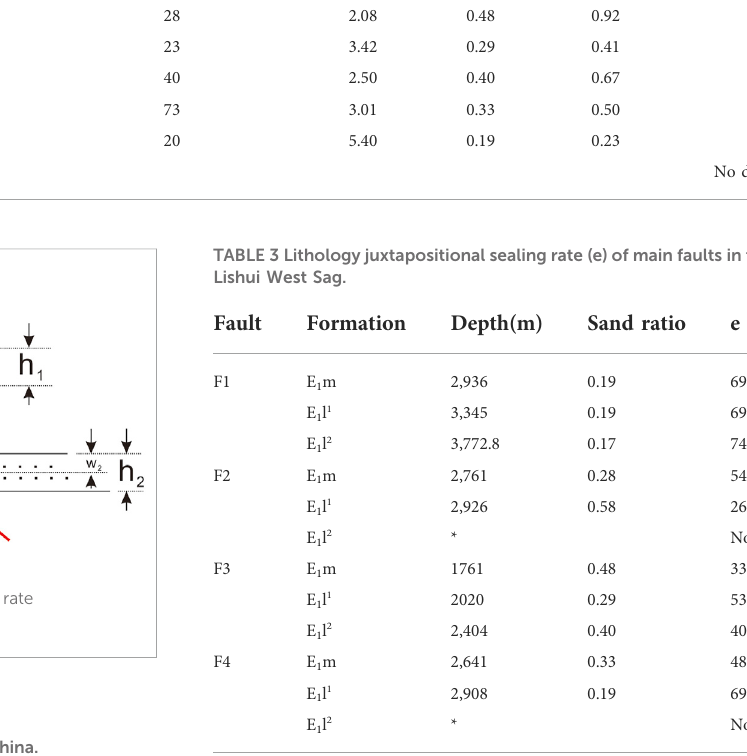
TABLE 2 Published data on similar basins in East China.